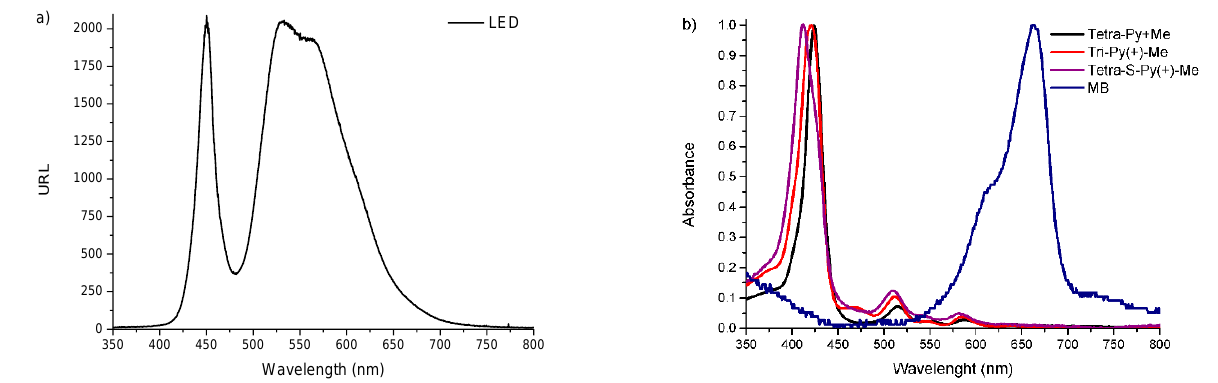
Figure 7. ( a ) LED emission spectra and ( b ) normalized UV-Vis absorption spectra of all PSs. All the irradiances were measured with a Power Meter Coherent FieldMaxII-Top combined with a Coherent PowerSens PS19Q energy sensor.